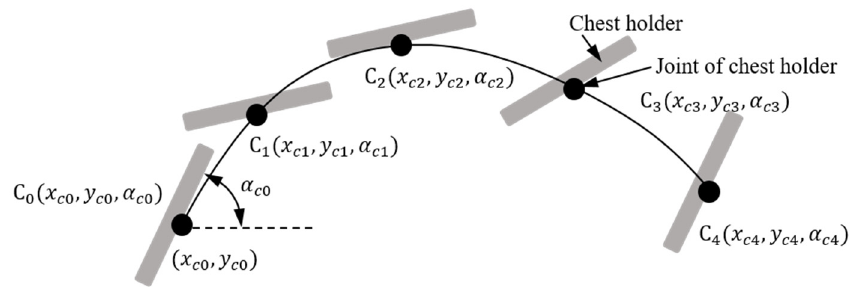
Figure 7. Realization of the motion trajectory for lifting.